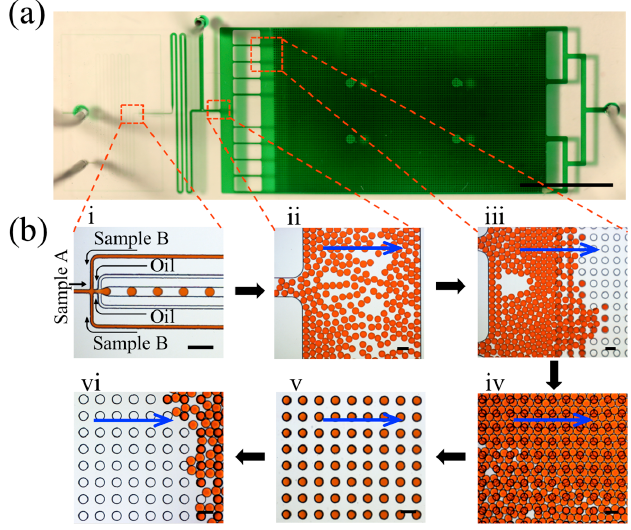
Figure 4. Images depicting the workflow for the Floating Droplet Array. ( a ) Photographic image of entire microfluidic device. The device was filled with green dye for visualization, scale bar = 1 cm; ( b ) Microscopic images of the workflow including (i) droplet generation, (ii) droplet loading into the chamber, (iii) droplet trapping, (iv) filling the chamber, (v) purging extraneous droplets, and (vi) droplet recovery by flipping. Blue arrows in (ii–vi) represent flow direction. All scale bars for (b) = 200 μ m.